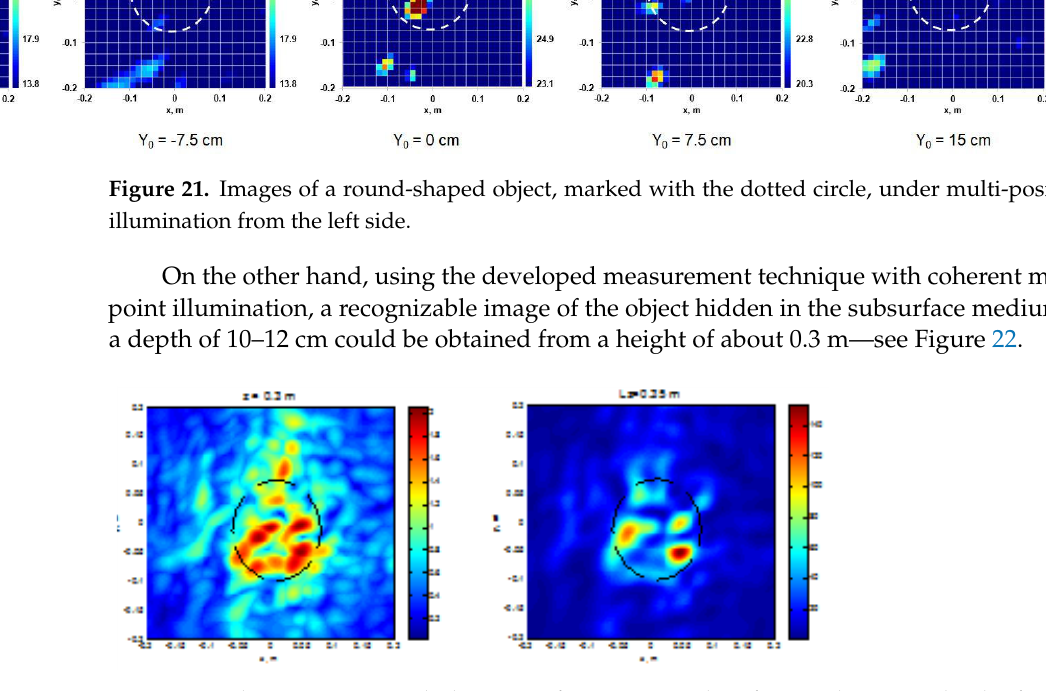
Amplitude ( a ) and coherent ( b ) multi-view summation.